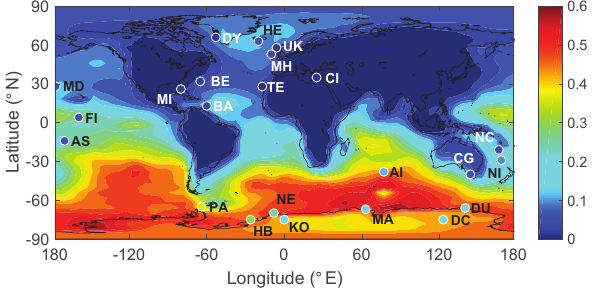
Figure 11. Global distribution of annual-mean surface MSA / nssSO 2 − molar ratios from the full model run ( R all ), 4 overplotted with observed annual-mean surface MSA / nssSO 2 − ratios from 23 stations around the